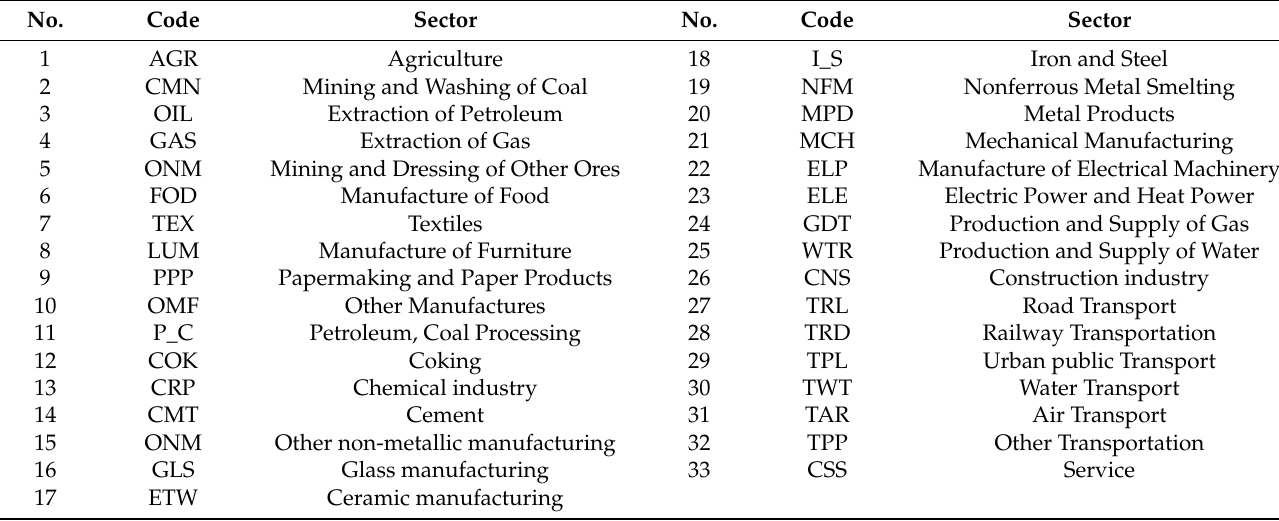
Table 1. Classification of production sectors.